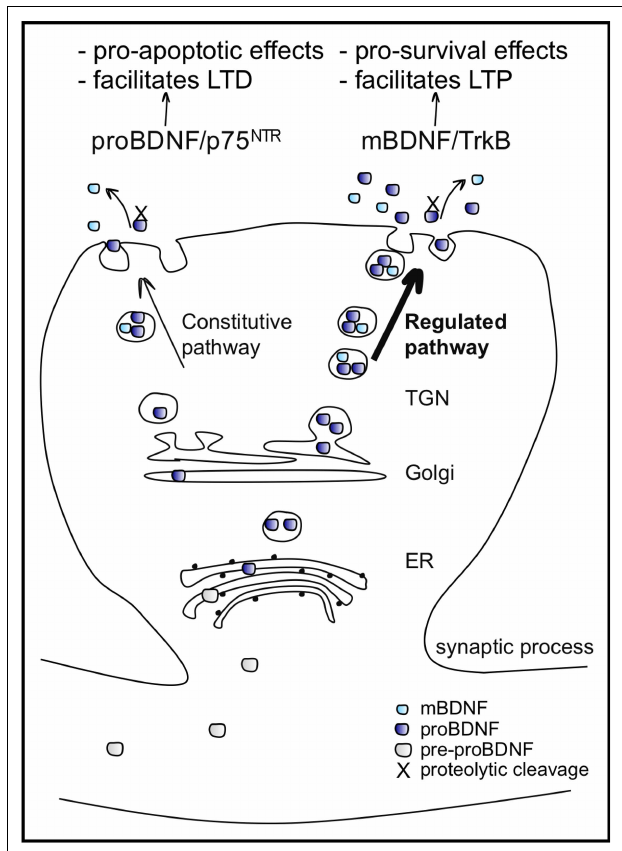
FIGURE 2 | BDNF processing, packaging and secretion in neurons. BDNF is synthesized as a pre-proBDNF protein, which has its pre-sequence cleaved off in the endoplasmic reticulum (ER). The resulting 32-kDa proBDNF moves, via the Golgi apparatus, into the trans-Golgi network (TGN) where two kinds of secretory vesicles are generated: those of the constitutive secretory pathway and those of the regulated pathway, whose secretion is activity-dependent. ProBDNF packaged in both types of vesicles is either proteolytically cleaved and secreted as 14-kDa mBDNF, or secreted as proBDNF and cleaved by extracellular proteases. The extent of the intra and extracellular processing of proBDNF is not exactly clear, but secretion of the proBDNF predominates. Both proBDNF and mBDNF are preferentially packaged into vesicles of the regulated secretory pathway. Once released, proBDNF binds preferentially to pan neurotrophin receptor p75 NTR and mBDNF binds preferentially to both pre-and post-synaptic TrkB receptors, activating different intracellular secondary messenger cascades and affecting distinct cellular